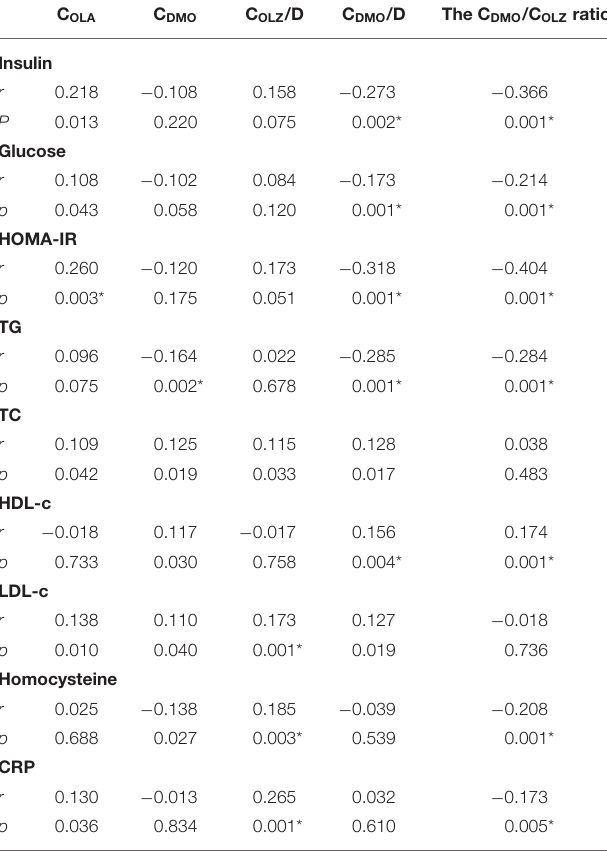
TABLE 2 | Correlations of C OLA, C DMO, C OLA /D, C DMO /D and the C DMO /C OLA ratio with metabolic parameters. C